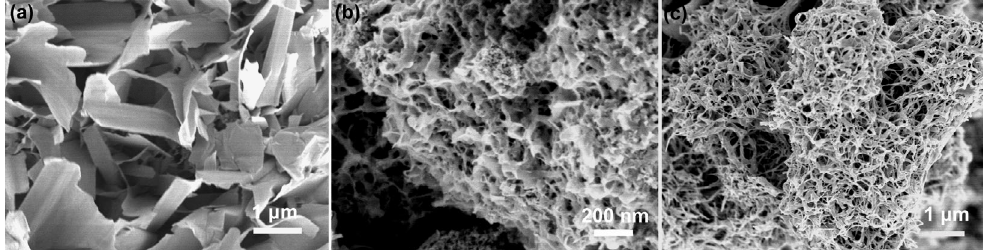
Fig. 2 SEM images of the CoSe 2 samples synthesized in a mixed solvent (40 mL, V DETA : V H CTAB: (a) 0 mmol (Sample A), (b) 0.75 mmol (Sample A), and (c) 3 mmol (Sample